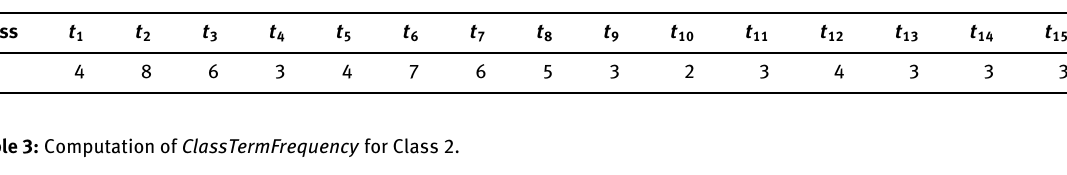
Table 2: Computation of ClassTermFrequency for Class 1.